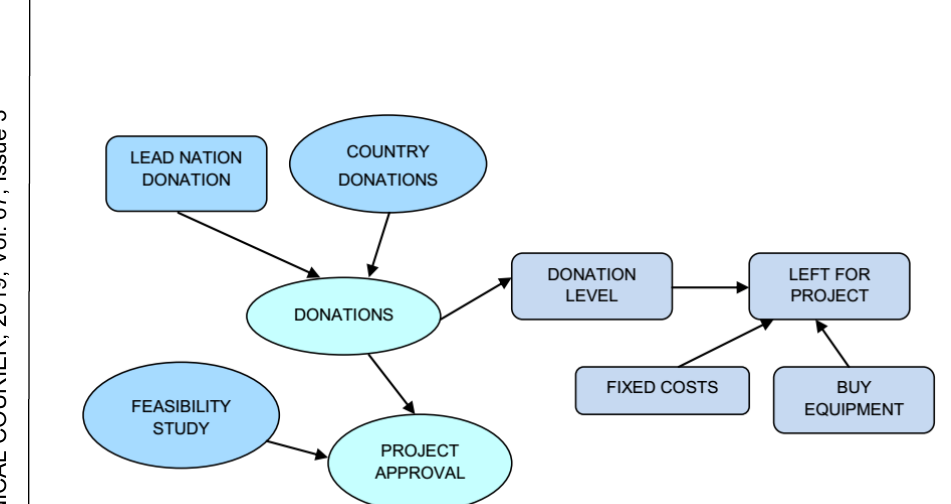
Figure 2 – Basic Trust Fund model in the AgenaRisk environment Рис . 2 – Базовая модель проекта , представленная в программном обеспечении Слика 2 – Основни модел пројекта приказан у